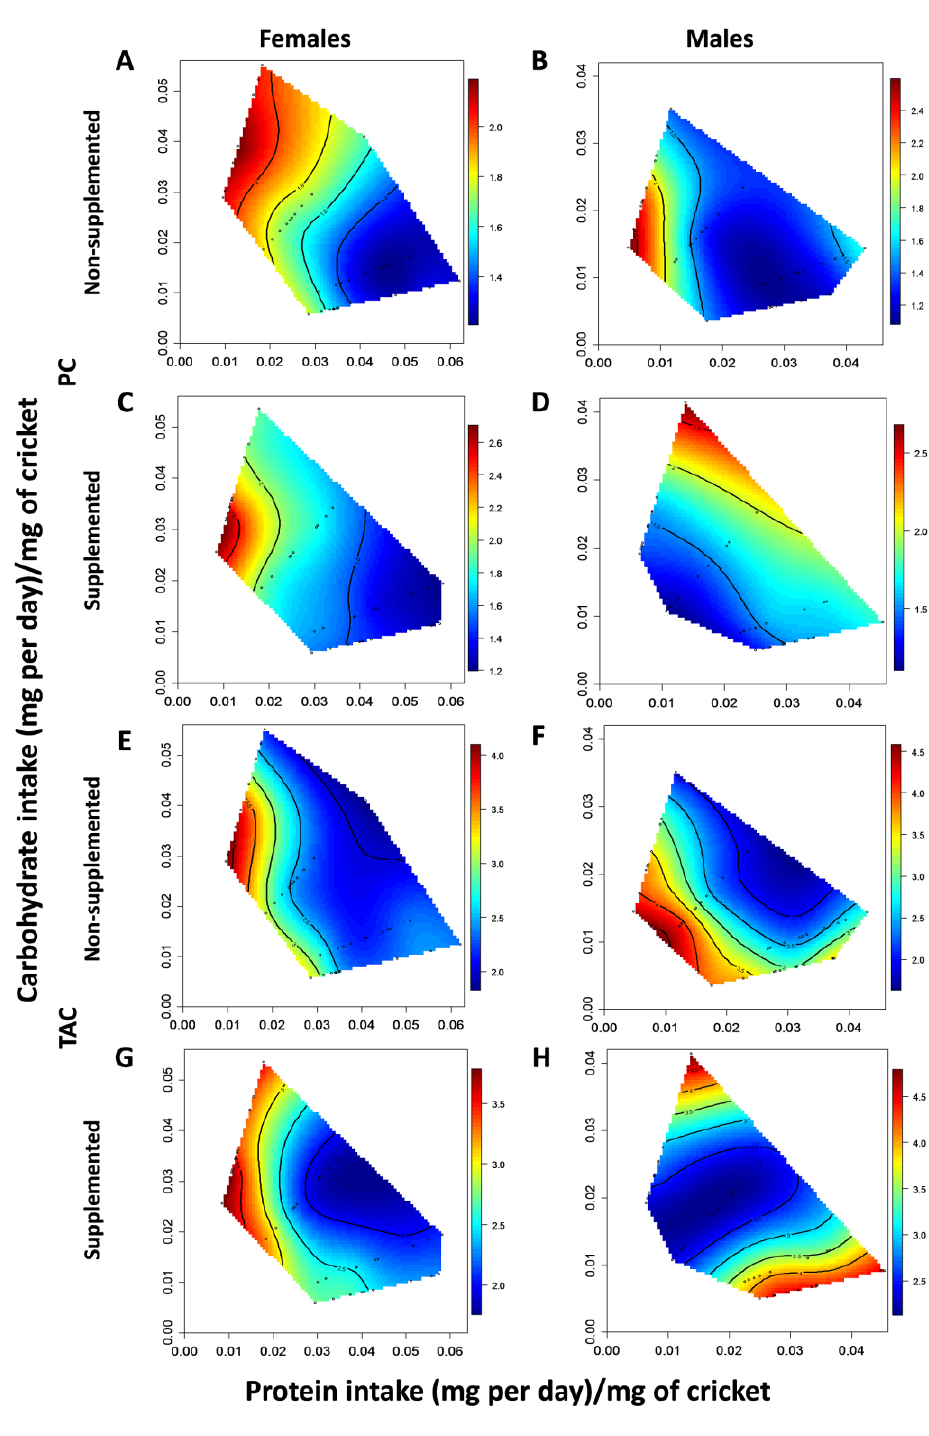
Figure 2. Nutritional landscapes illustrating the effects of daily protein and carbohydrate intake on oxidative damage to proteins (PC, A – D ) antioxidant capacity (TAC, E – H ) in female ( A , C , E , G ) and male ( B , D , F , H ) crickets that were supplemented with DL-alpha-tocopherol ( C , D , G , H ) or not ( A , B , E , F ). The scale associated with each graph is shown to its right: the values for each scale bar are presented per mg of protein in cricket homogenate (PC: nmol, TAC: mmol). High values of these traits are in red and low values in blue. Black dots represent the actual intake of nutrients by individual